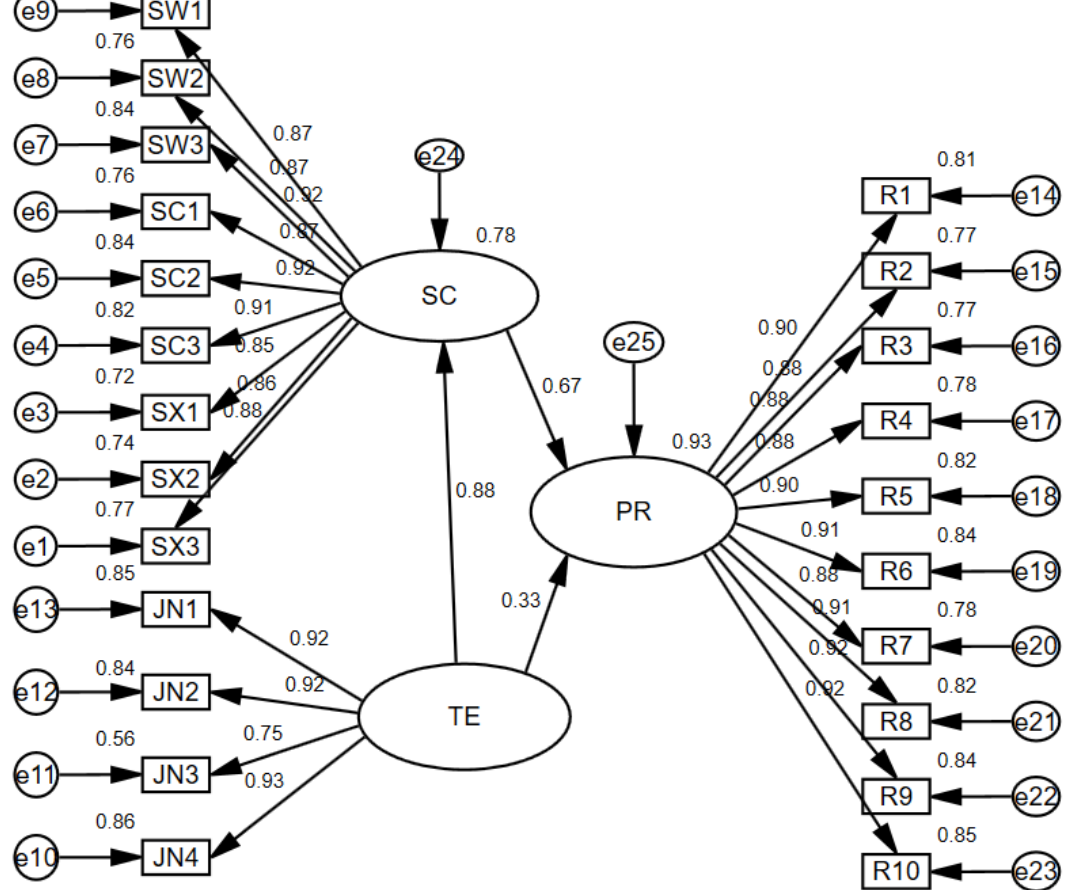
Figure 2. Structural model for PR. PR, Pandemic resilience; SC, Social Capital; TE, Technological of Empowerment.